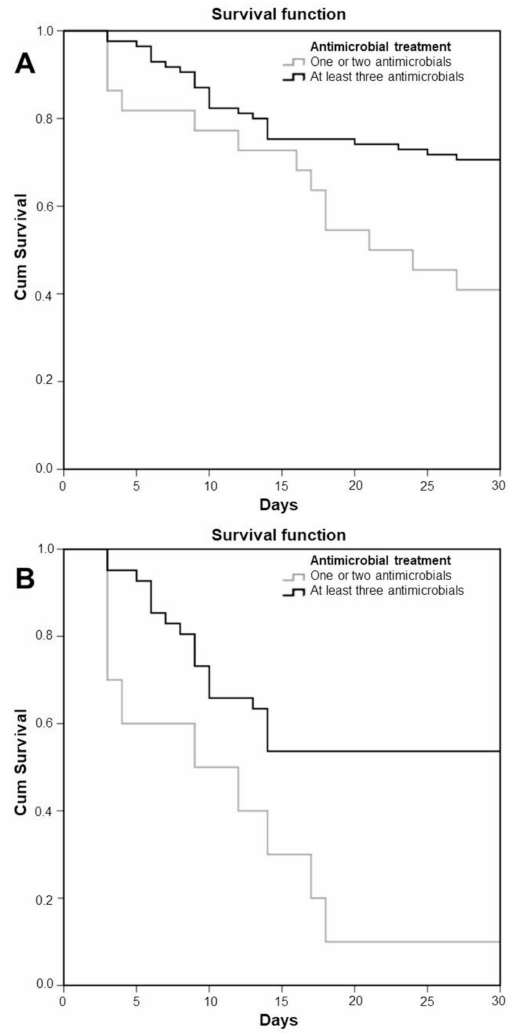
Figure 1. Kaplan–Meier curve of survival probability of patients with PDR-Kp BSIs according to number of administrated antimicrobials. ( A ): all patients ( p = 0.001); ( B ): patients with septic shock ( p =